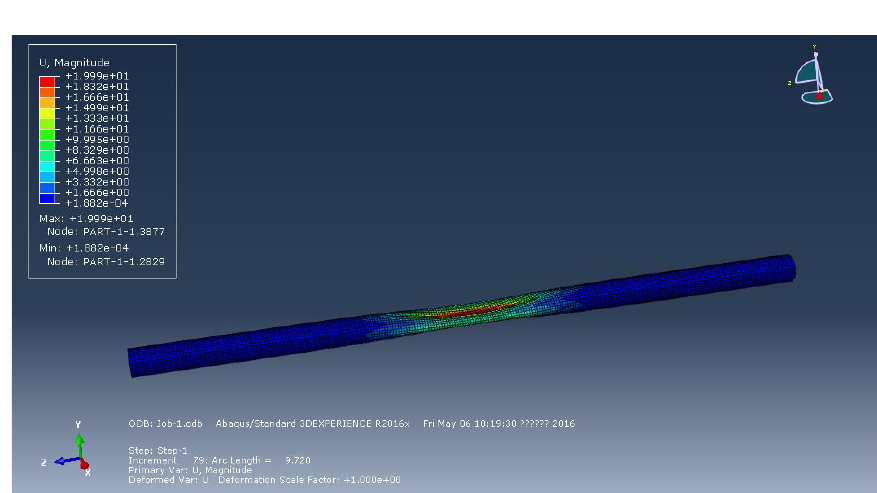
Figure 4. Deformation of pipeline at ellipticity of 0.15.